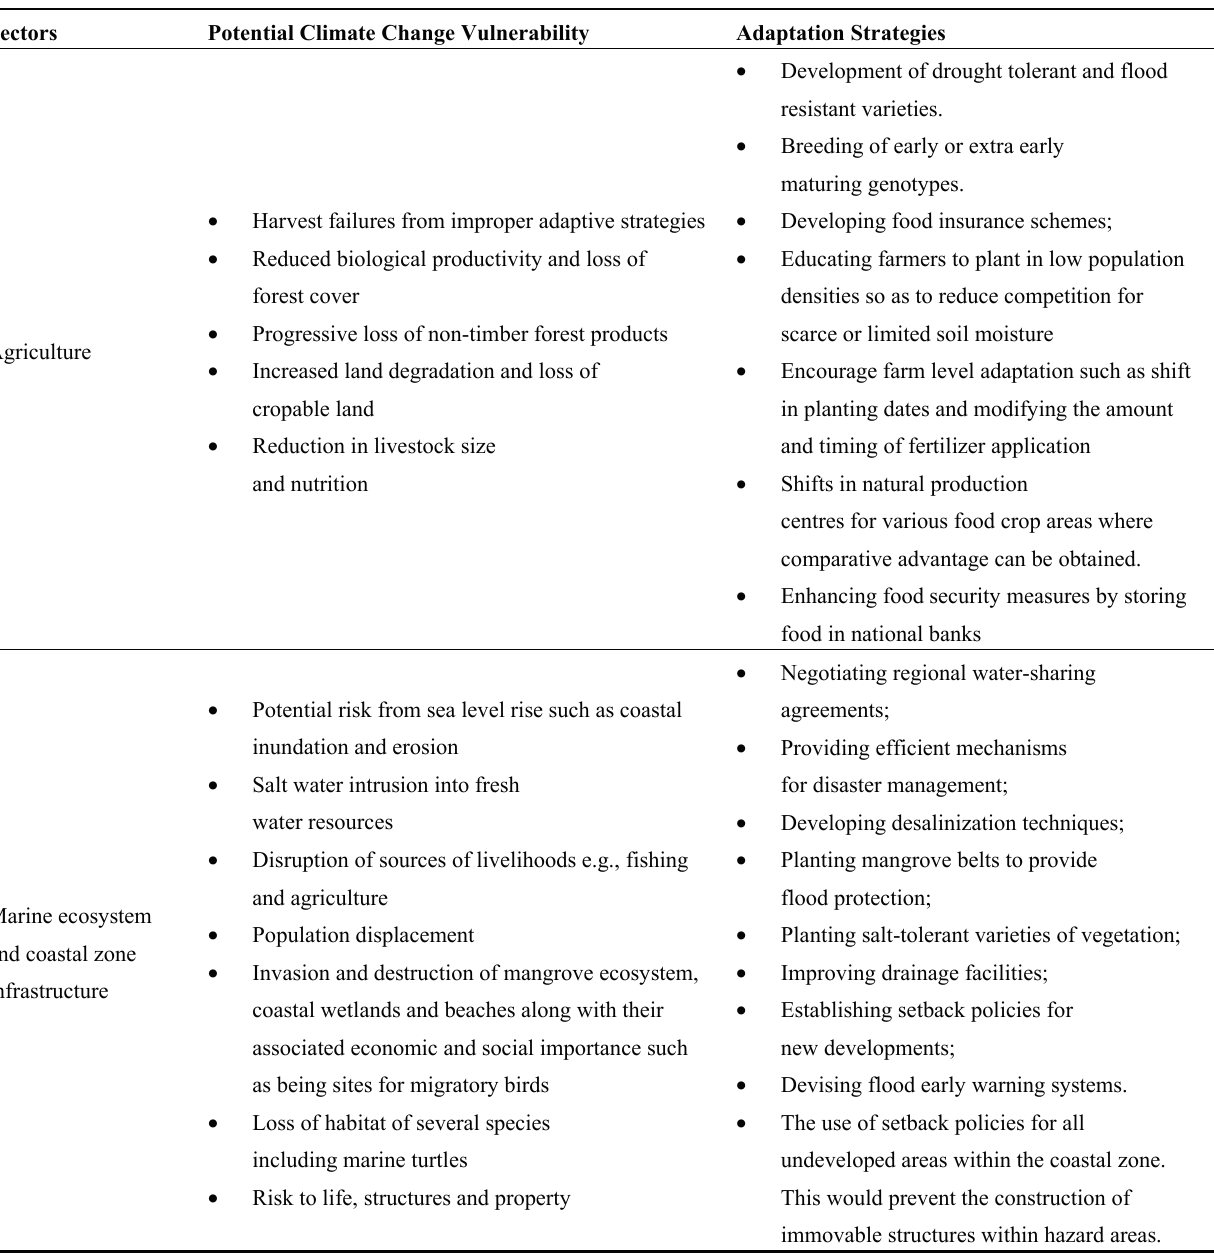
Table A3. Potential Climate Impacts and Proposed Adaptation and Mitigation Strategies. Source: Authors’ compilation from